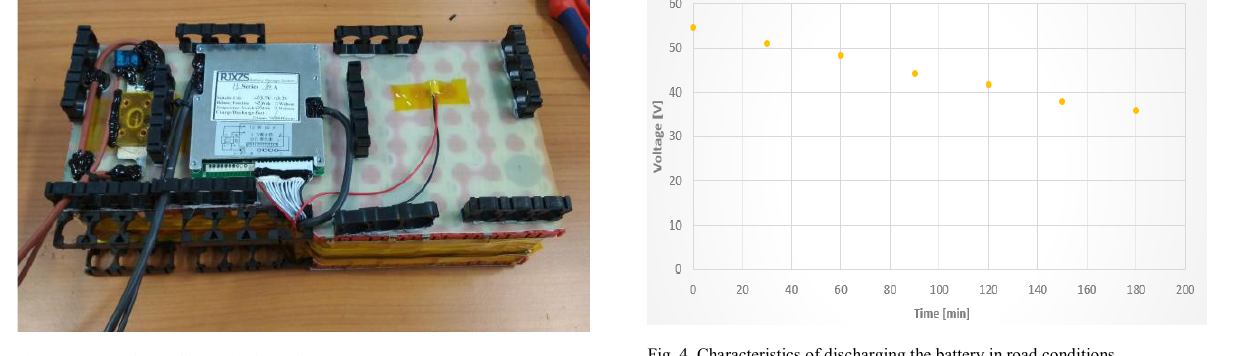
Fig. 2. Battery after welding of cells and BMS system